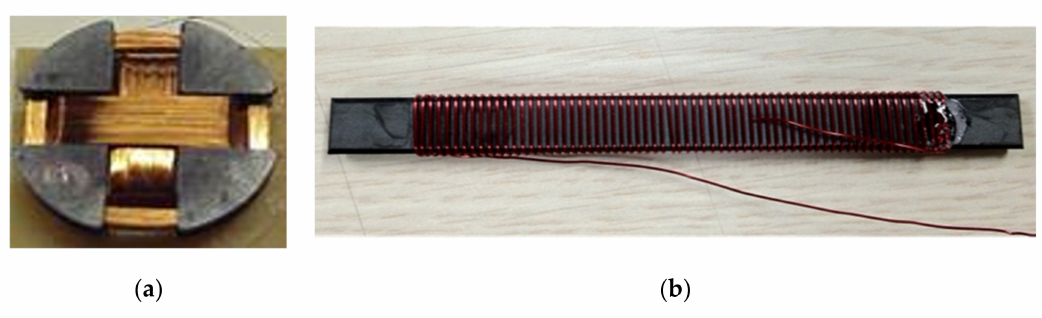
Figure 3. Ferrite antennas used in the automotive field. ( a ) Keyless entry system; ( b ) smart key